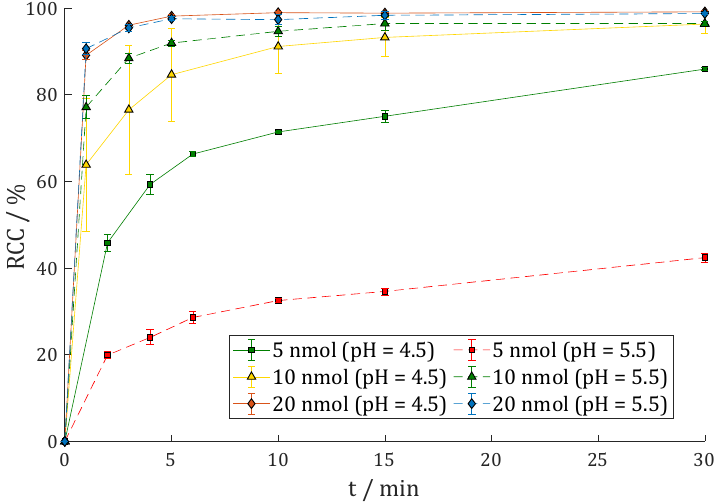
Figure 6. Reaction kinetics (radiochemical conversion (RCC) in %) of [ 68 Ga]Ga ‐ DO3A.Glu.(FAPi) 2 68 Ga ‐ 11 in 1 M HEPES (pH = 4.5 or 5.5) at 95 °C with 100 MBq 68 Ga (n = 3).